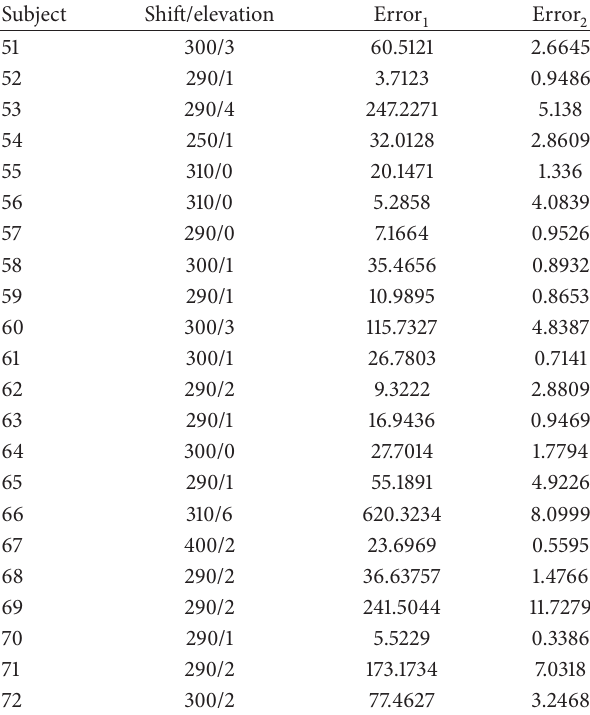
Table 1: Experimental results of removing the baseline